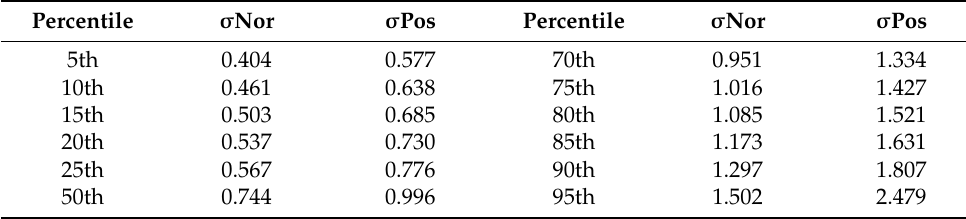
Table 3. Percentile distribution of the CVI in the two groups.